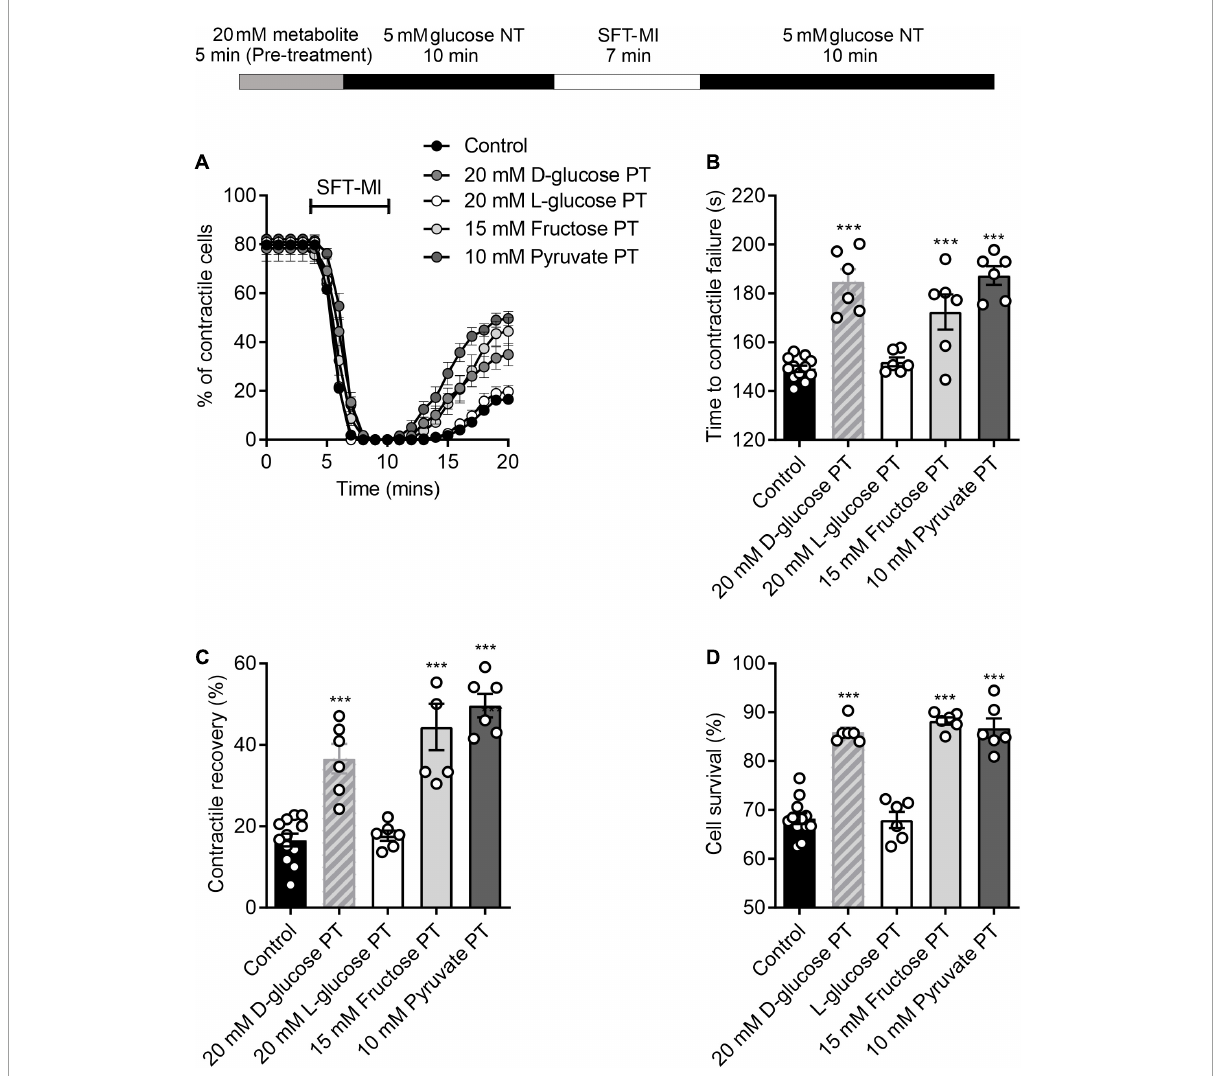
FIGURE5 Protection afforded by high glucose pre-treatment can be mimicked with other glycolytic metabolites. (A) Example time course showing the percentage of contractile cells during the MI/R protocol following 5 min pre-treatment with 20 mM glucose, 15 mM fructose, 10 mM pyruvate, or 20 mM L-glucose. (B) Bar chart showing mean time to contractile failure. All pre-treatments show a significant delay in the time to contractile failure, except for L-glucose, which is a non-metabolised enantiomer [** P < 0.01, *** P < 0.001, One-Way ANOVA with Holm-Sidak post-test, n = 6 ( > 98 cells) for each group]. Bar charts showing (C) the percentage contractile recovery and (D) cell survival at the end of the MI/R protocol. In each case there is a significant increase in contractile recovery, except for the L-glucose pre-treated group [*** P < 0.001, One-Way ANOVA with Holm-Sidak post-test, n = 6 ( > 102 cells) for each